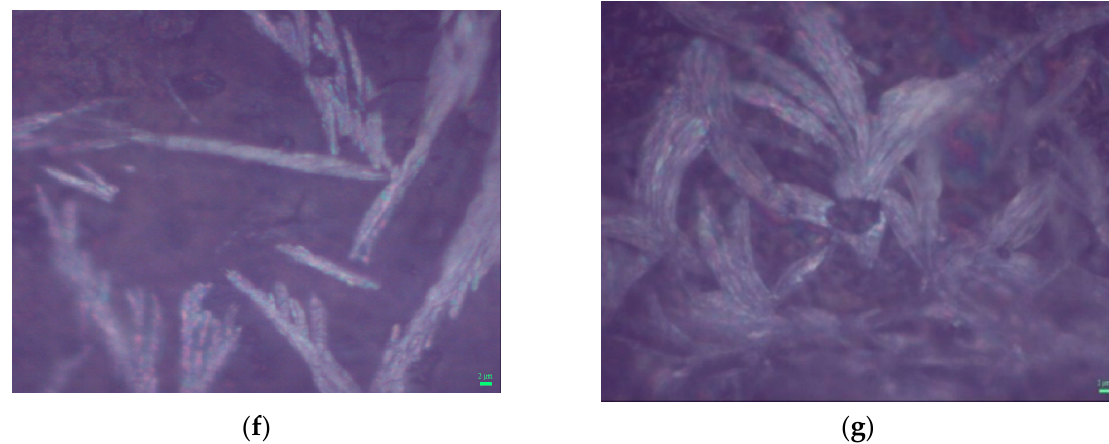
( f ) ( g ) Figure 1. The Raman spectrum of the screen-printed carbon electrodes modified with reduced graphene oxide and polydiphenylamine (SPCE-RGO/PDPA) platform before ( a ) and after the interaction with the 1,4-phenylene diisothiocyanate (PDITC) solution in ethanol (1 mL) with a concentration equal to 0.5 ( b ), 1 ( c ), 2 ( d ), and 4 mg mL − 1 ( e ). ( f , g ) show the optical images of the platform SPCE-RGO/PDPA after the interaction with the PDITC solution having the concentration equal to 0.5 and 4 mg mL − 1 . All spectra are recorded at the excitation wavelength of 514 nm.